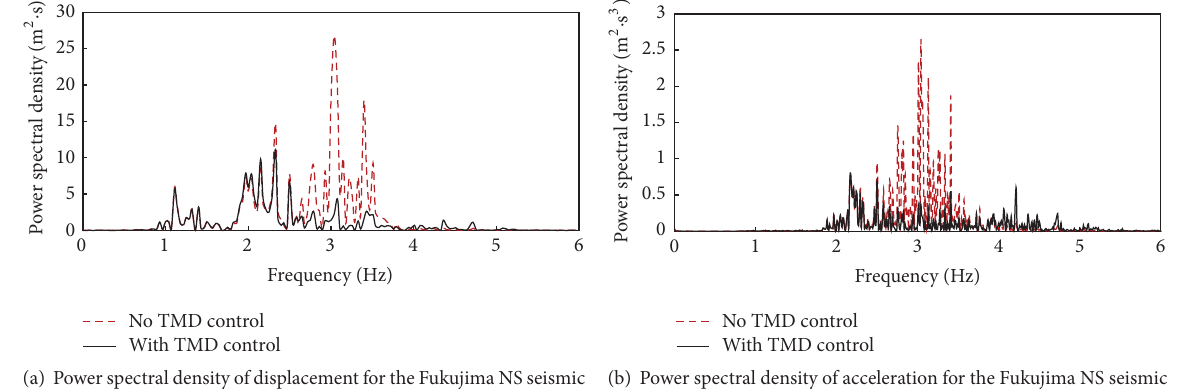
Figure 11: Power spectral density of the displacement of the platform with and without bufferable TMD, under the Fukujima NS seismic waves (a) and the Taft EW seismic waves (b).